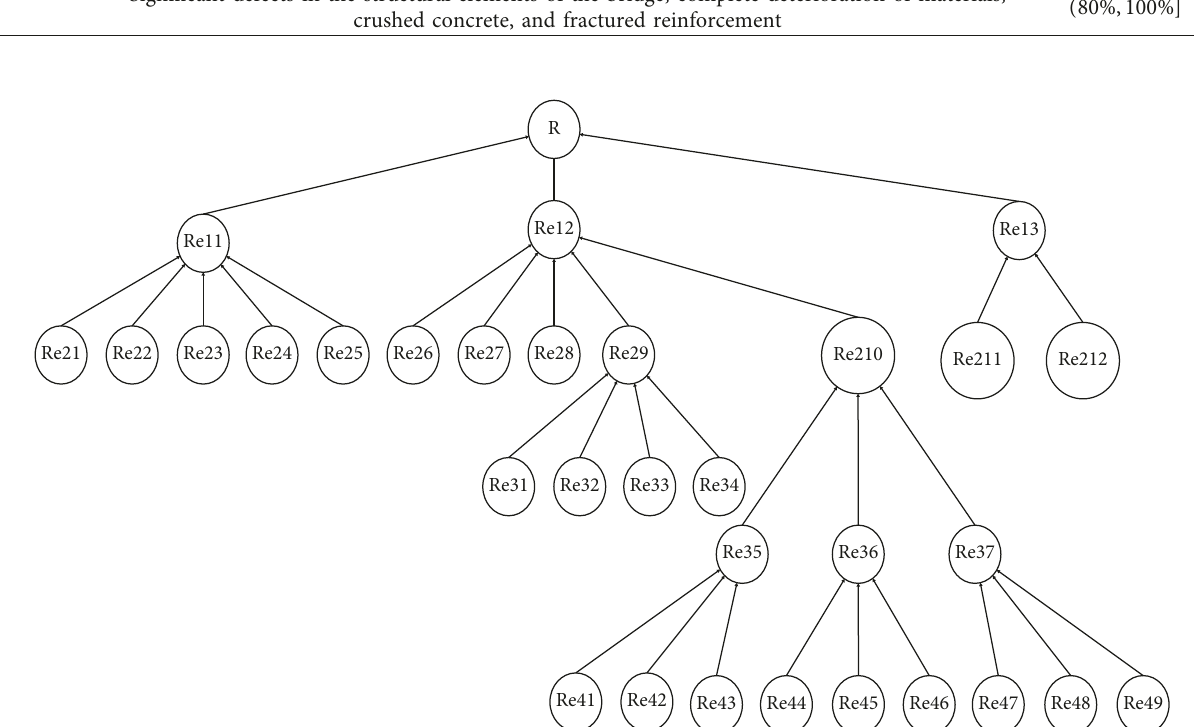
Figure 1: Bayesian network structure of existing railway